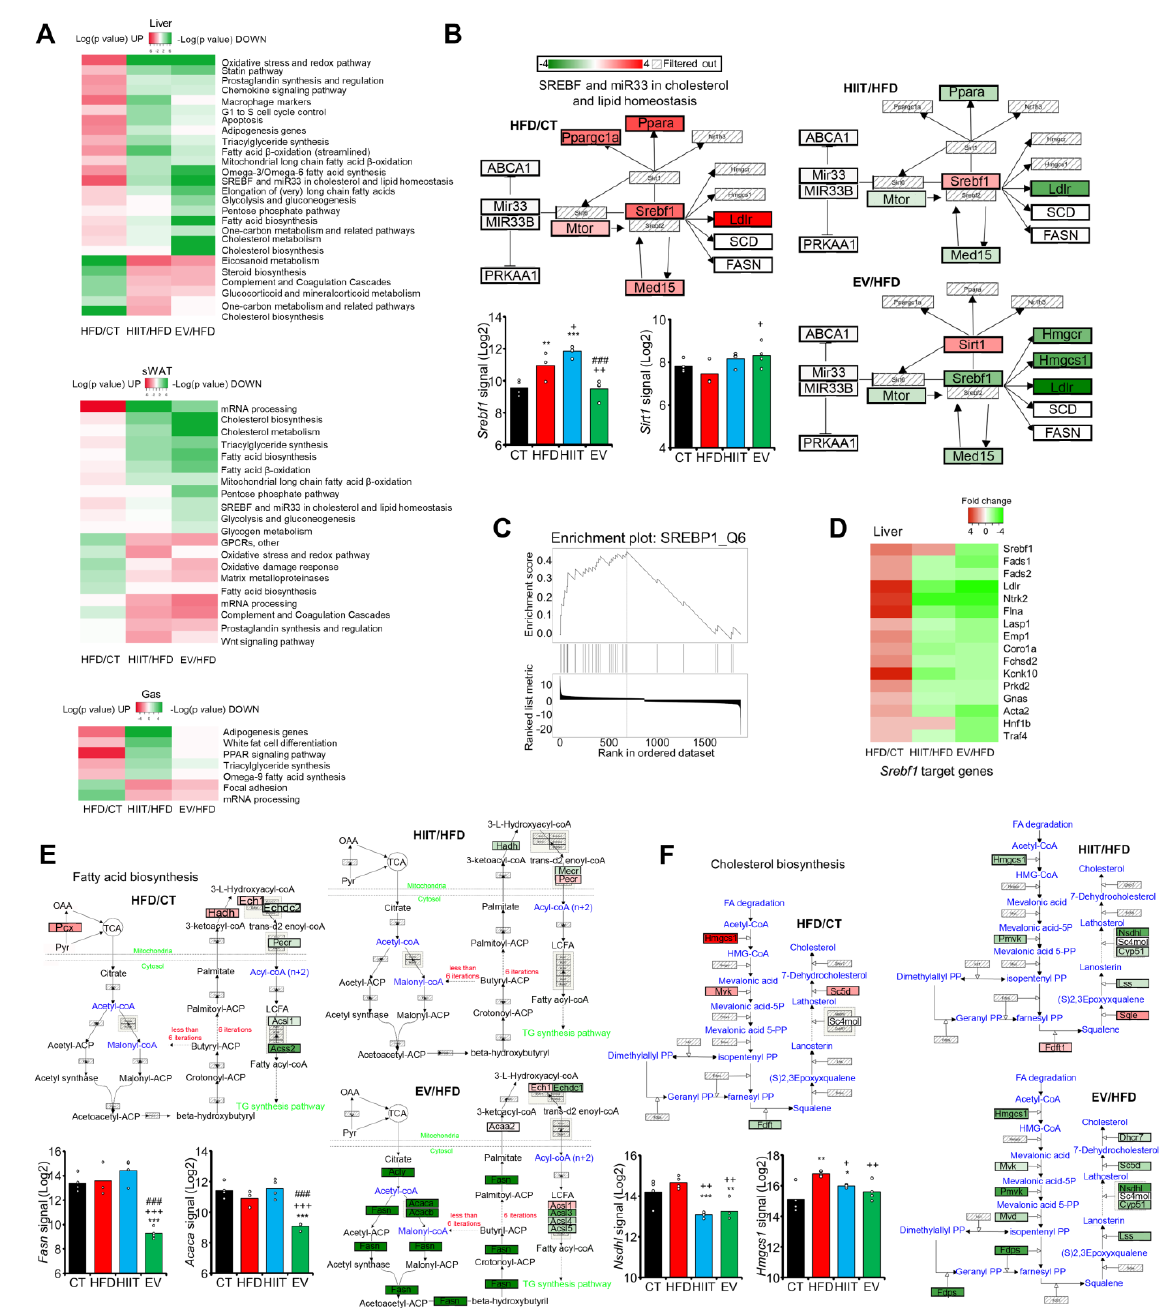
Figure 7. EV-miRNAs regulate hepatic lipid metabolism to decrease steatosis: ( A ) Heatmaps showing the log( p -value) of pathways enriched in upregulated (red, represented as − log( p -value)) or downregulated (green, represented as log( p -value)) genes in HFD/CT, HIIT/HFD, and EV/HFD. ( B ) The obesity-upregulated cholesterol and lipid homeostasis was normalized only by EV treatment in the liver. ( C ) Gene set enrichment analysis identified SREBP1 as a candidate transcription factor governing gene expression in EV livers. ( D ) SREBP1 target genes were decreased by EV treatment. ( E ) The fatty acid biosynthesis pathway was decreased specifically in EV livers. ( F ) Differentially enriched pathways with respect to the HFD group and sample signals of principal genes of interest in sWAT show a larger effect of EV-miRNAs on cholesterol biosynthesis. n = 4/group ( A – F ); * p < 0.05, ** p < 0.01, *** p < 0.005 with respect to the CT group; + p < 0.05, ++ p < 0.01, +++ p < 0.005 with respect to the HFD group; ### p < 0.005 between the HIIT and EV